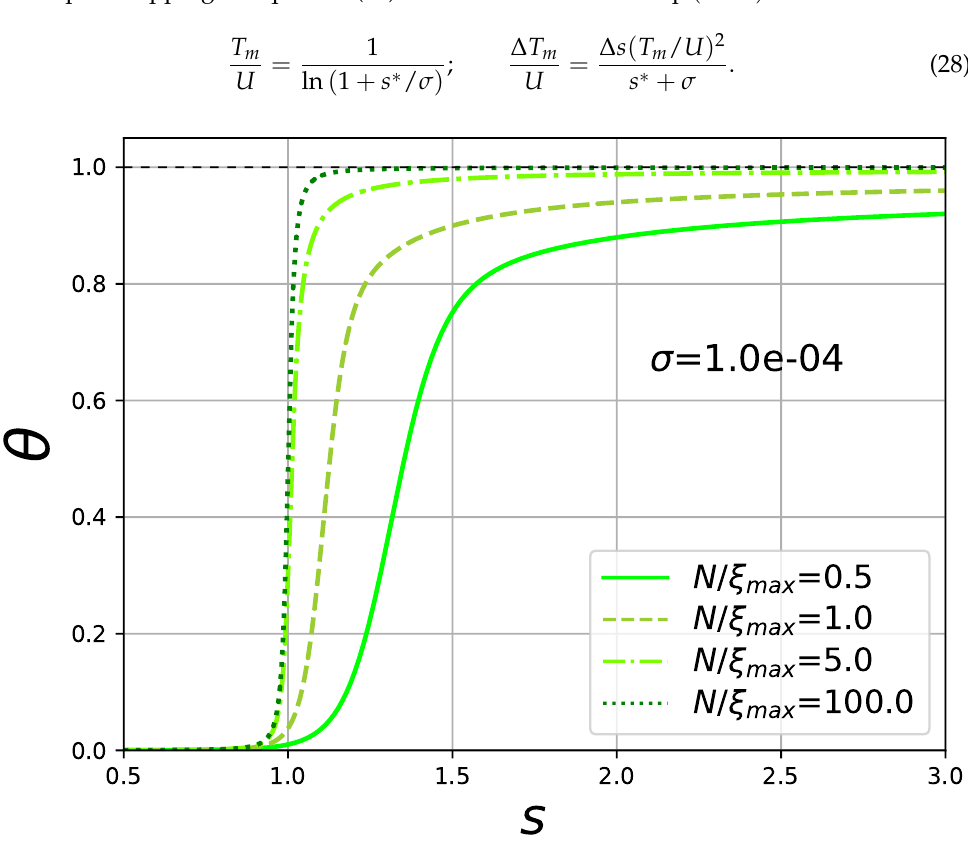
Figure 3. Helicity degree θ over a range of stability parameter s at different values of reduced chain lengths N / ξ max ; cooperativity parameter σ = 0.0001 is same for all the